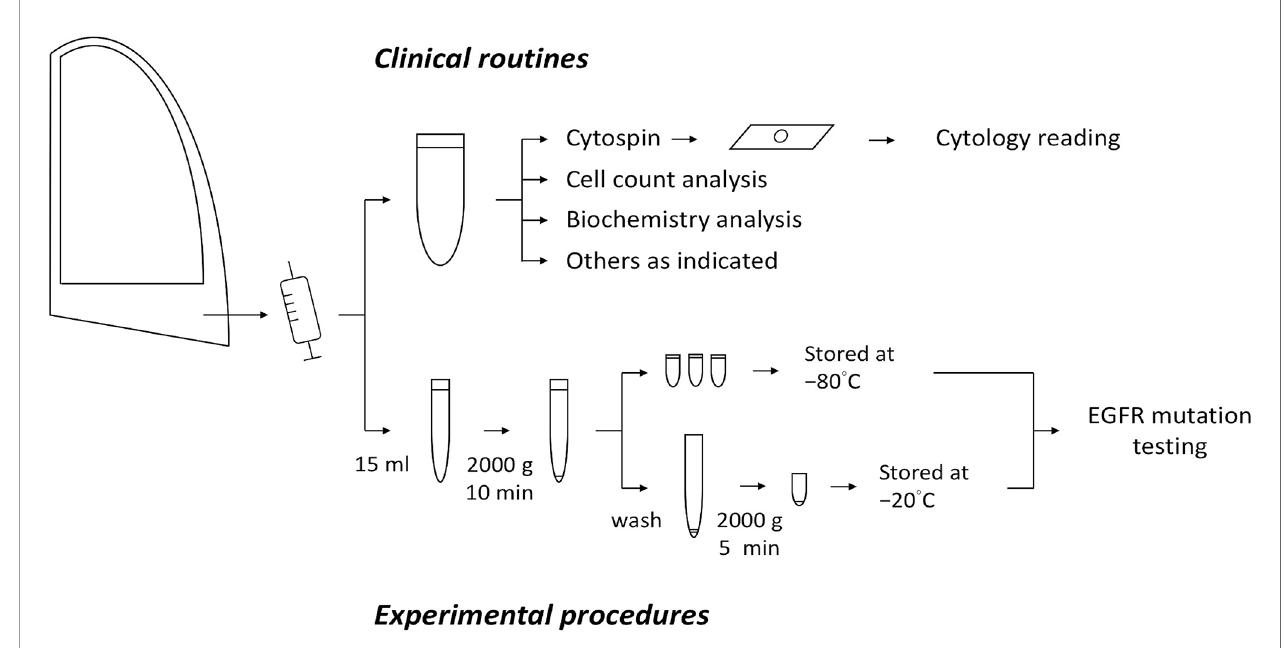
FIGURE 1 | The experimental procedures in this